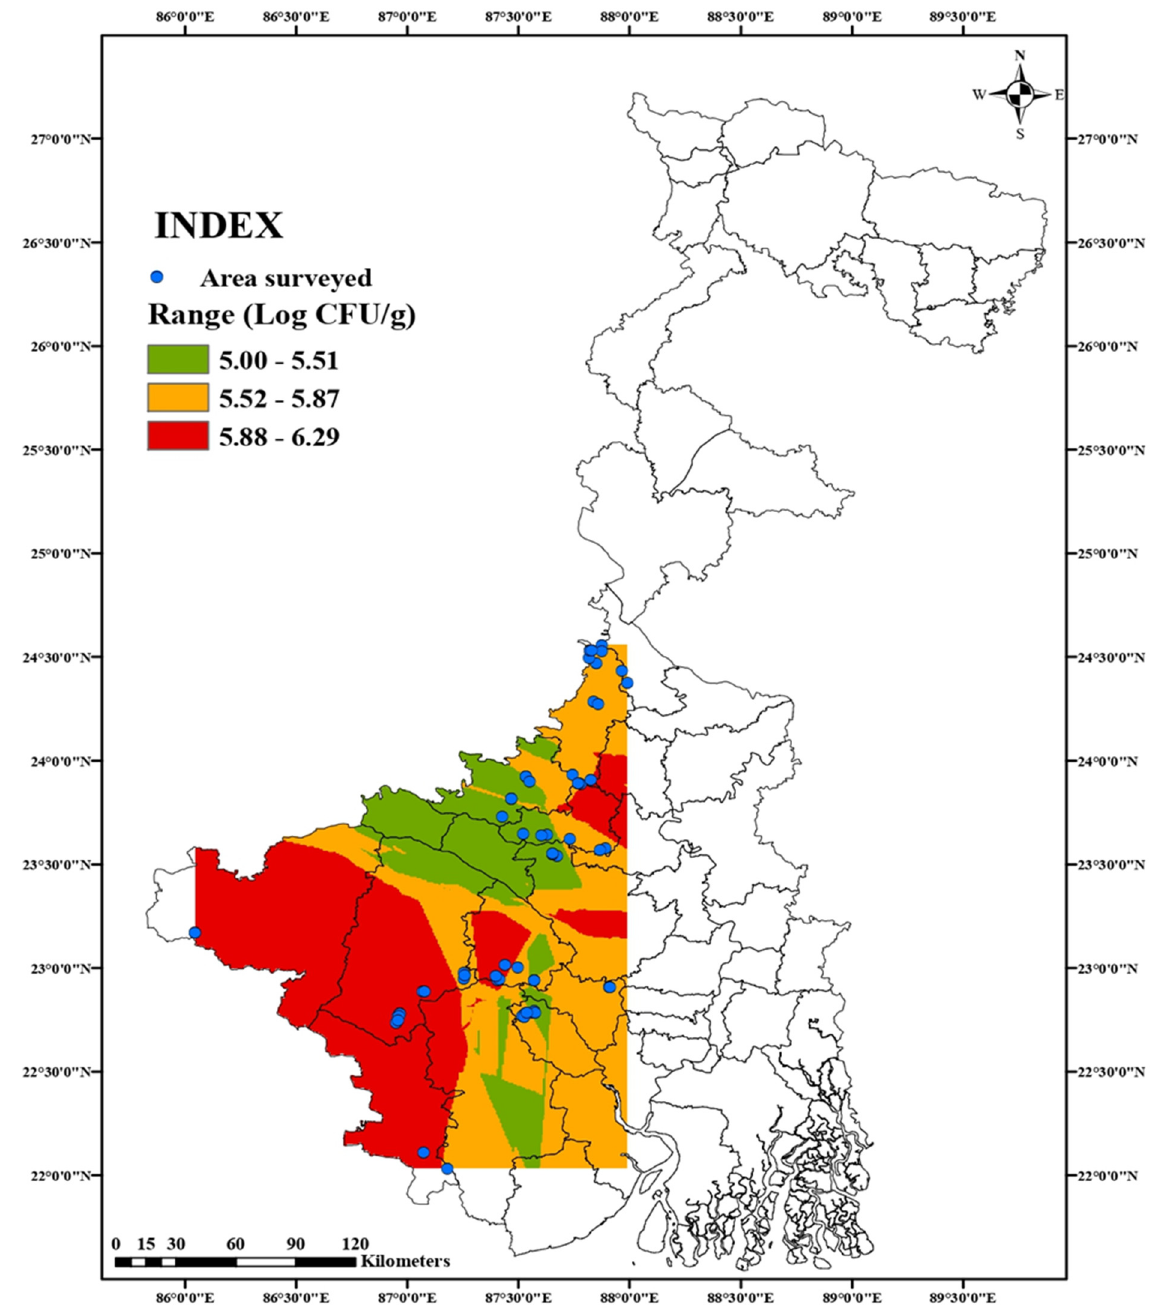
Figure 1. Population of the culturable Pseudomonads and related genera in different areas of red and lateritic regions of West Bengal. The map is prepared by ArcMap 10.3.1 software. Survey locations are marked as blue circles. The colour indicating the range of population near the surveyed regions are based on the probability of software.